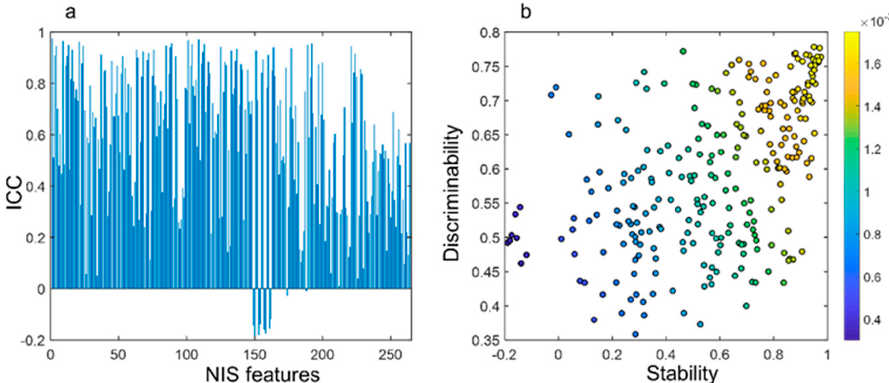
Figure 5. NIS stability and discriminability analysis. ( a ) Moderate to high stability of 264 NIS features with ICC > 0.6. ( b ) Feature significance as a function of stability and discriminability.